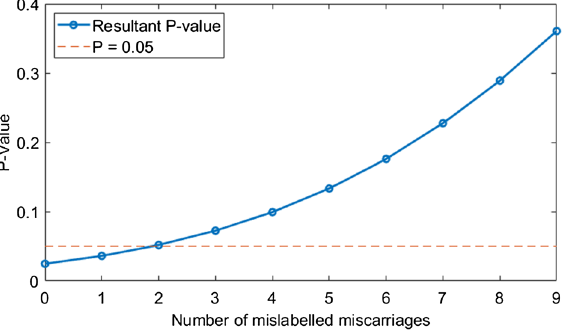
Figure 2. A discrepancy of 9 women in the full sample can mean anything from 0–9 mislabelled miscarriages, with strong implications for the ostensible significance of the result. Dotted line depicts α = 0.05 significance level.